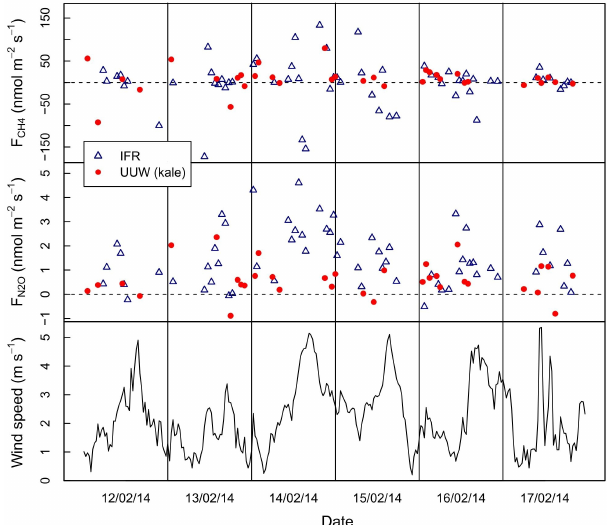
Figure 6. Daily mean fluxes of CH 4 (top) and N 2 O (middle) at the IFR site, using the GGR method (dots) and using the NSR method (triangles). In these two panels, error bars in insets indicate for each method (GGR left, NSR right) the median of the standard error of the daily mean flux. Bottom panel: volumetric water content at 5cm